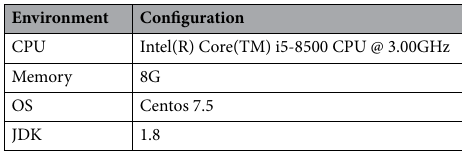
Table 3. Experimental environment Configuration.